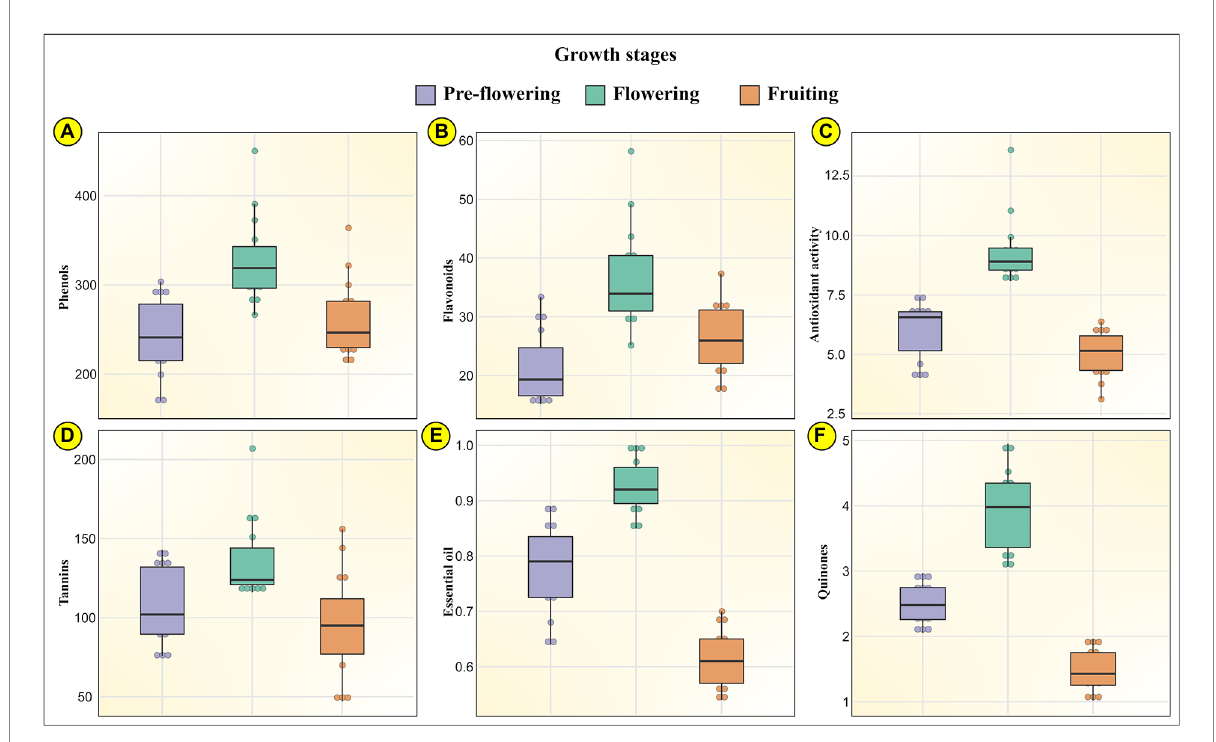
FIGURE 4 Represents the phytochemical profile of MK ( Murraya koenigii (L.) Spreng.) leaves through Box and Whisker Plots at the three developmental stages (pre-flowering, flowering, and fruiting) for (A) phenols; (B) flavonoids; (C) antioxidant activity; (D) tannins; (E) essential oils; and (F)